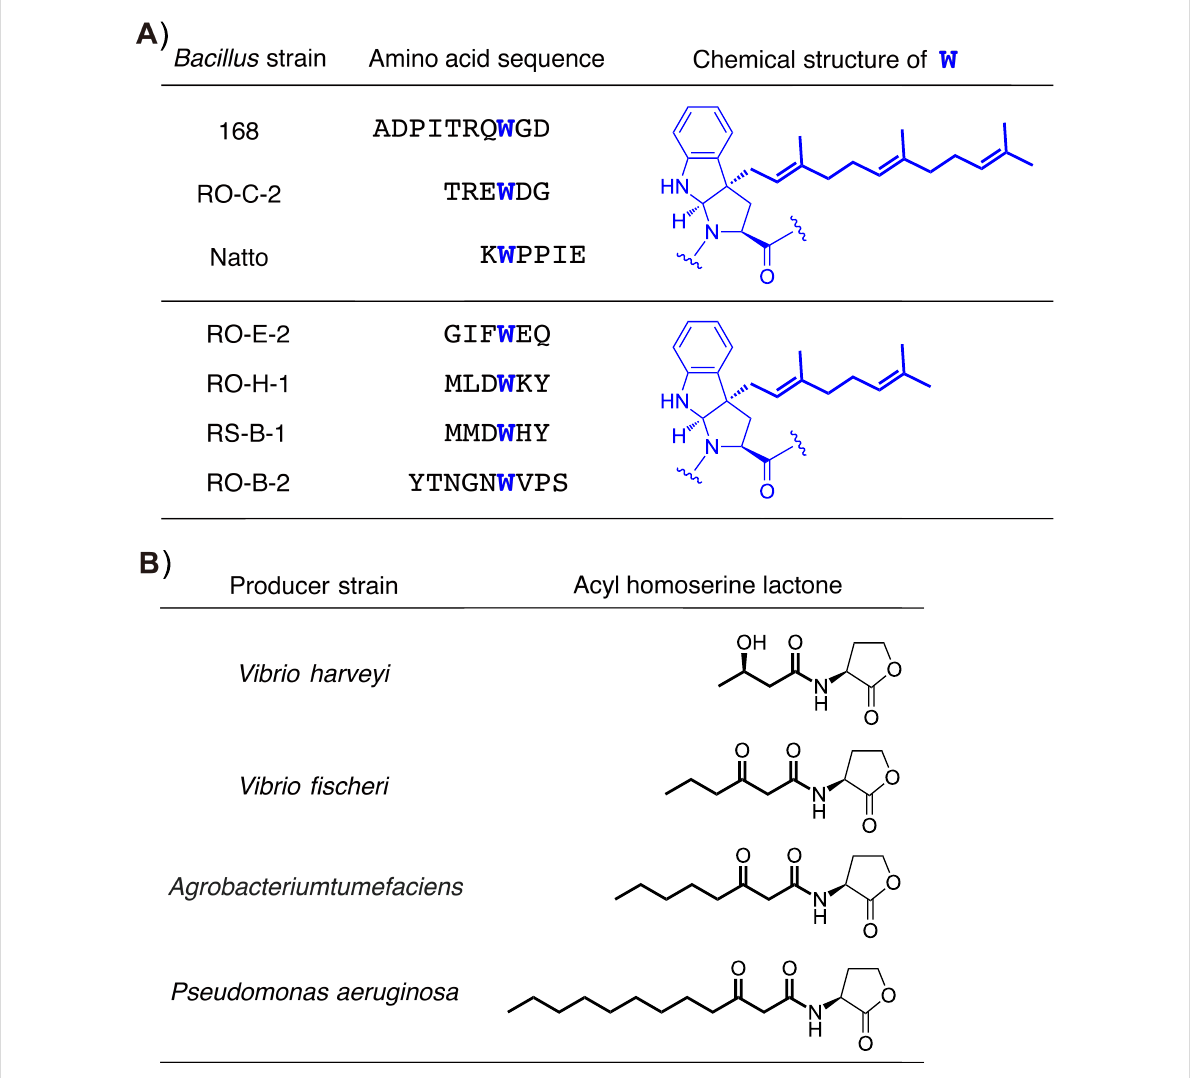
Figure 3: (A) Two types of posttranslational isoprenylations of ComX variants. The modified tryptophan residues are colored blue. The isoprenyl side chains are shown in boldface and colored blue. (B) Chemical structures of acyl homoserine lactones. The acyl side chains are shown in boldface.